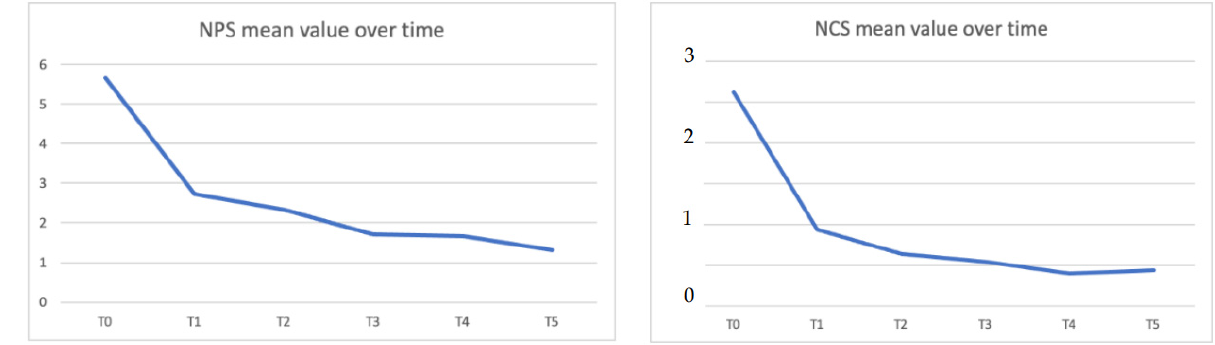
Figure 3. NPS (nasal polyps score) and NCS (nasal congestion score) mean values over time.